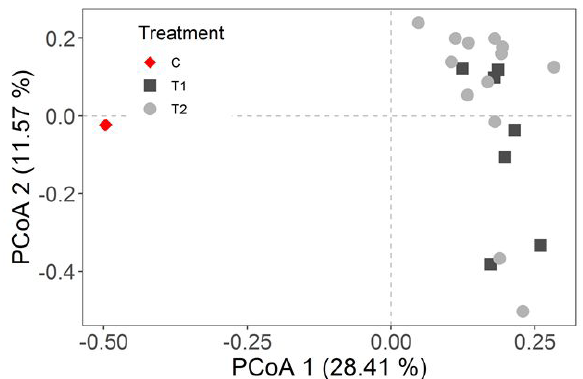
Figure 7. Ordination diagram of the Principal Coordinates Analysis (PCoA) based on the periphytic algal composi- tion from the control and food content of Moenkhausia sanctaefilomenae between T1 (without zooplankton) and T2 (with zooplankton) treatments.